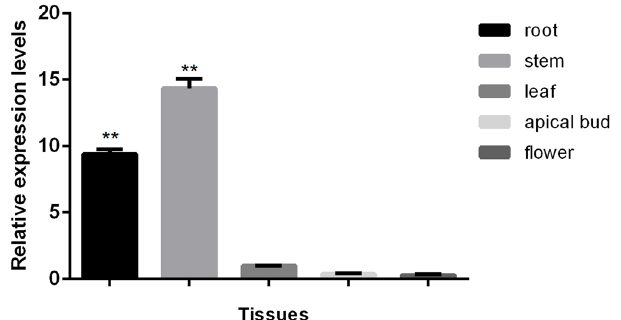
Figure 2. CvGME expression in various tissues isolated from C. vestitum . Data showed as mean ± SD of three independent experiments. Asterisks indicate values that are significantly different from those of leaf ( p < 0.01).